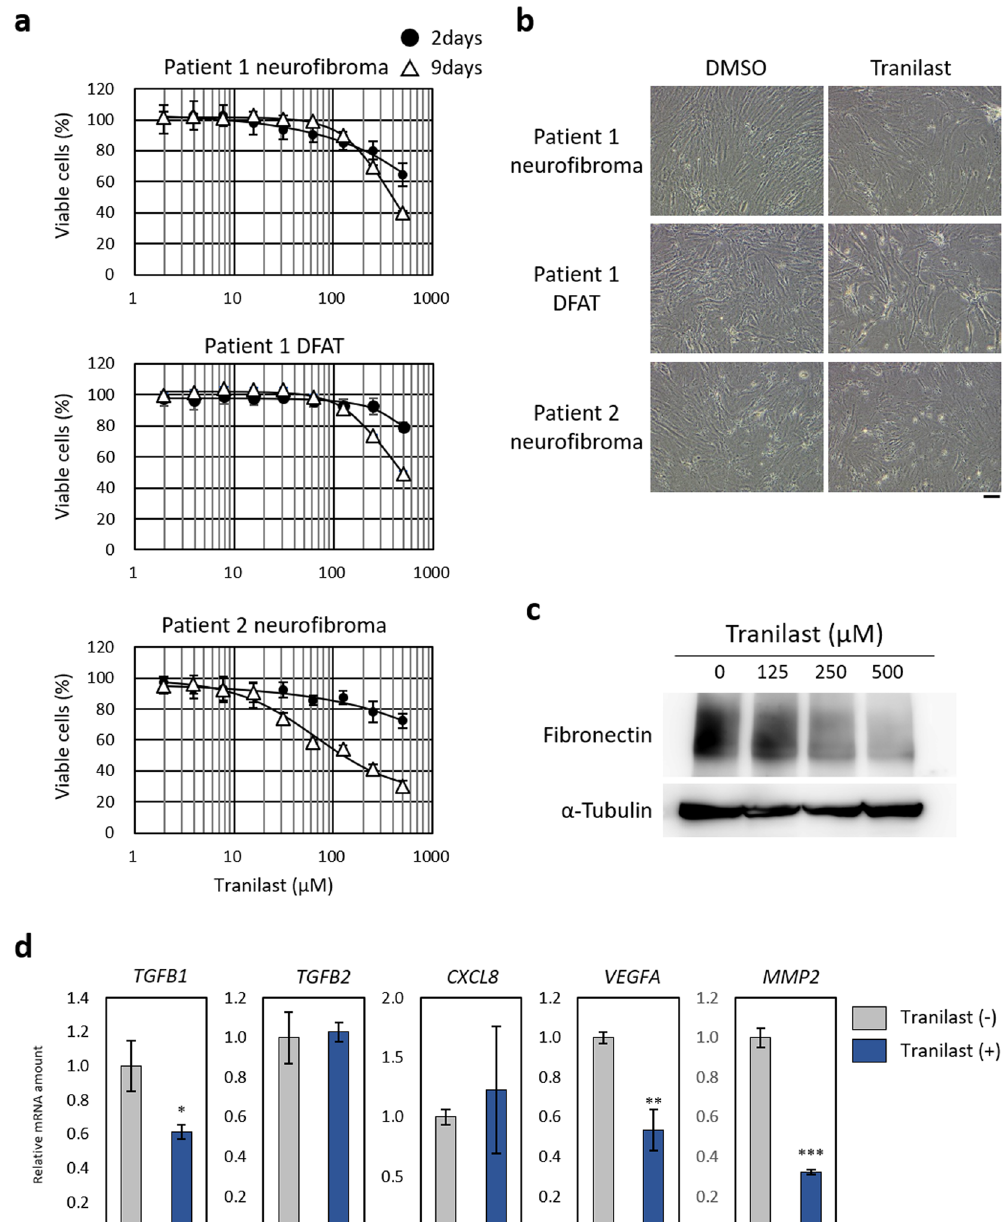
Figure 7. Tranilast suppresses proliferation as well as mesenchymal marker and angiogenesis-related gene expression in cells derived from neurofibromas of NF1 patients. ( a ) Neurofibroma cells or DFAT cells of two patients were cultured in the presence of various concentrations of tranilast for 2 or 9 days, after which cell viability was determined with the CellTiter-Glo assay (Promega). Data are means ± s.d. for six replicates of representative experiments. ( b ) Phase-contrast microscopy of cells incubated with 250 µ M tranilast or DMSO vehicle for 9 days as in a. Scale bar, 100 µ m. ( c ) Immunoblot analysis of fibronectin in neurofibroma cells of patient 1 that had been treated with the indicated concentrations of tranilast for 2 days. Blots are derived from different regions of different gels. Uncropped images are shown in Supplementary Fig. S6. ( d ) Quantitative RT-PCR analysis of mRNAs for TGF- β 1, TGF- β 2, IL-8, VEGF-A, and MMP2 in neurofibroma cells of patient 1 that had been incubated with or without 250 µ M tranilast for 9 days. Data are means ± s.d. for triplicates from a representative experiment. * P < 0.05, ** P < 0.01, *** P < 0.001 versus the corresponding control value (Student’s unpaired t